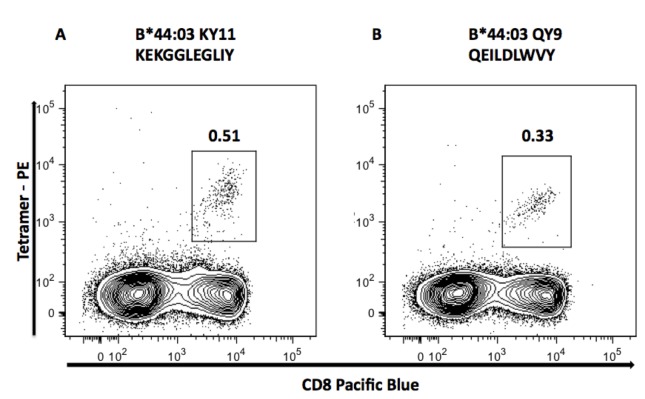
Confirmation of Nef-KY11 (KEKGGLEGLIY) and Nef-QY9 (QEILDLWVY) as novel HLA-B*44: 03 restrictedCD8 T cell epitopes using HLA-Class I tetramers. HLA-B*44: 03 tetramers were loaded with [A] Nef-KY11 and [B] Nef-QY9 optimal peptide and stained against donor PBMC’s from a C-clade infected B*44: 03 positive individual, subject R129 HLA-A*23: 01/30:04, B*08: 01/44:03, C*03:04/04:01. The number shown above each gate is the percentage of total lymphocytes that are tetramer-specific (tetramer positive cells expressed as a percentage of CD8+ cells were 1.48% for KY11 and 0.65% for QY9).